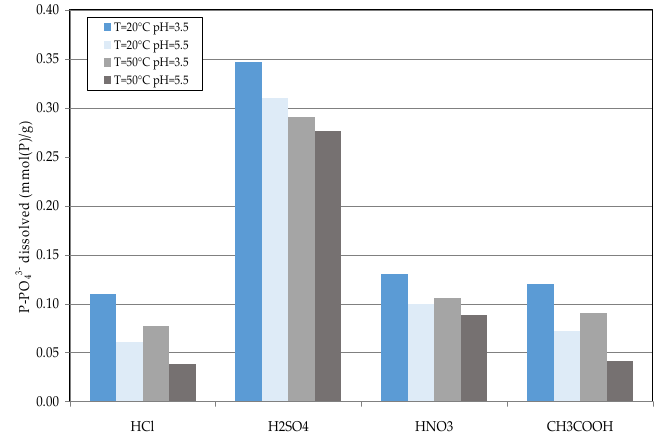
Figure 6. N-NH 4+ release (millimoles per gram of decomposed solids) detected during the struvite decomposition tests.